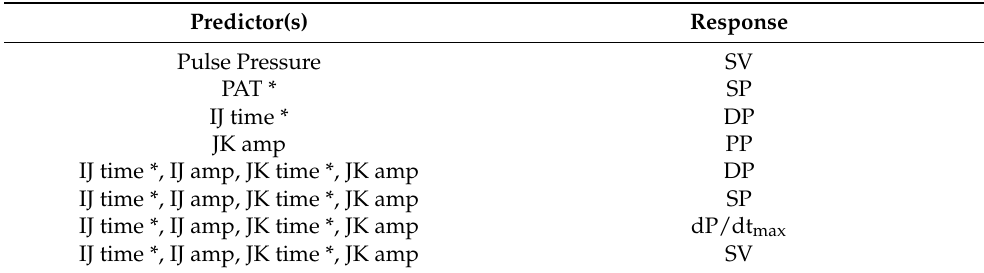
Table 3. Predictor(s)–response pairs. SV: stroke volume; SP: systolic pressure; DP: diastolic pressure; PP: pulse